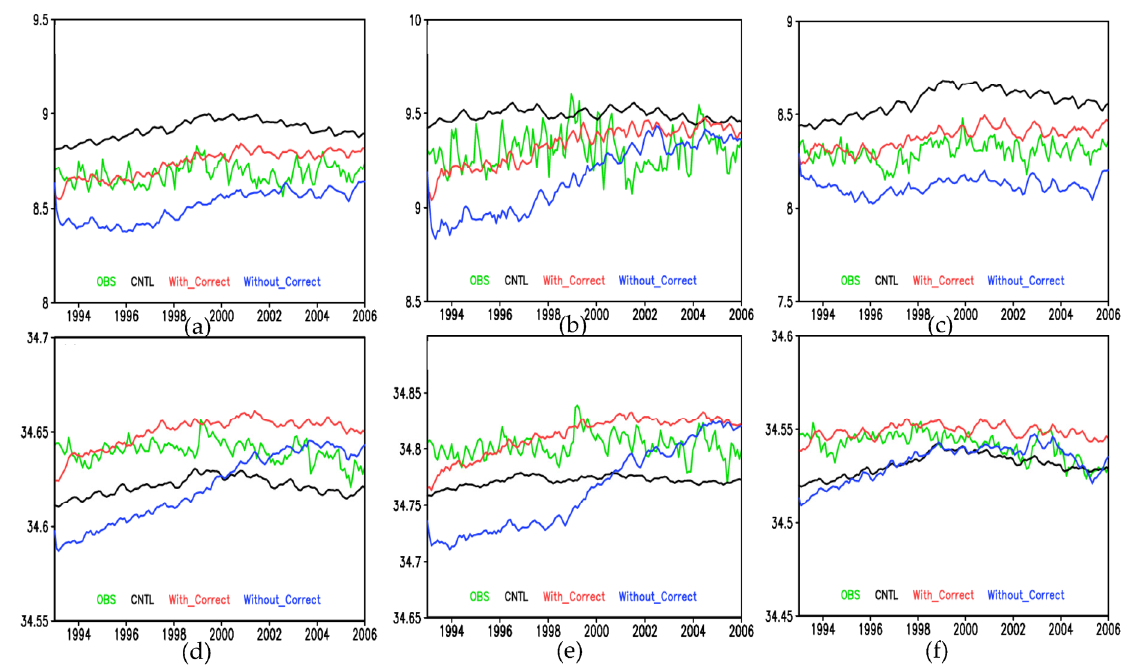
Figure 8. Time series of HC300–700 ( a – c ) and SC300–700 ( d – f ) averaged in different oceans from different experiments and observations. ( a , d ) Southern Indian and Southern Pacific oceans, ( b , e ) Southern Indian Ocean, ( c , f ) Southern Pacific Ocean.